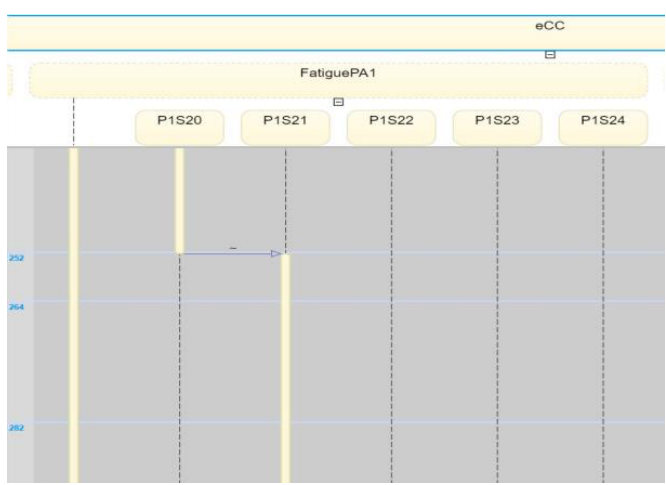
Figure 23. Dynamics of G 1 in terms of the fatigue symptom.